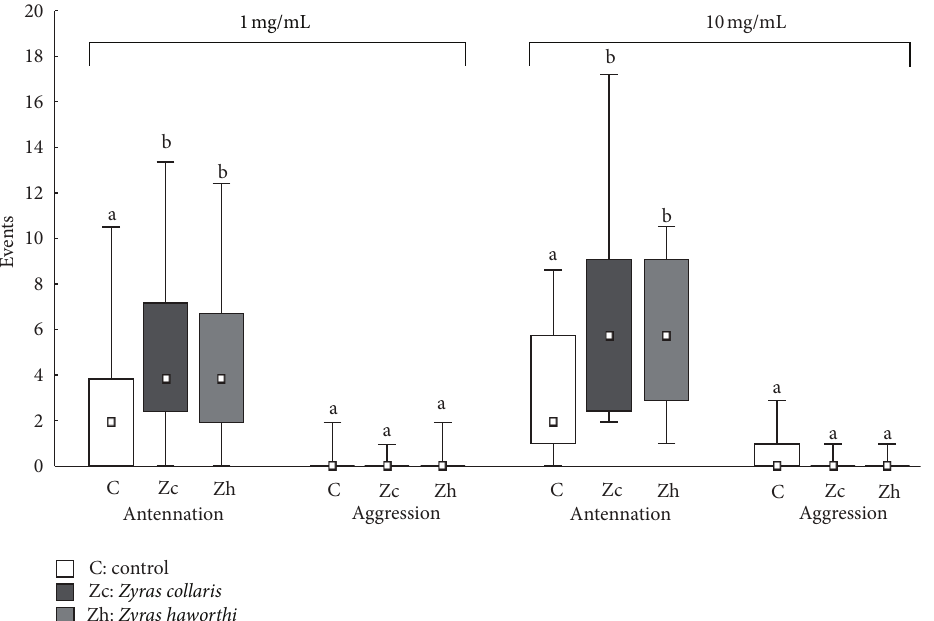
Figure 2: Antennation and aggressive behaviour ( ◻ : median, boxes: 25–75 percentiles, whiskers: min.–max.) by Lasius fuliginosus ants in a laboratory experiment towards a filter paper ball treated with mixtures of substances (1mg/mL and 10mg/mL), which are present in the tergal gland secretion of Zyras collaris and Z. haworthi rove beetles. Bars with different lower case letters are significantly different at 𝑃 ≤ 0.05 (Mann-Whitney 𝑈 -test; control: 𝑁 = 40 ; mixtures: 𝑁 = 20